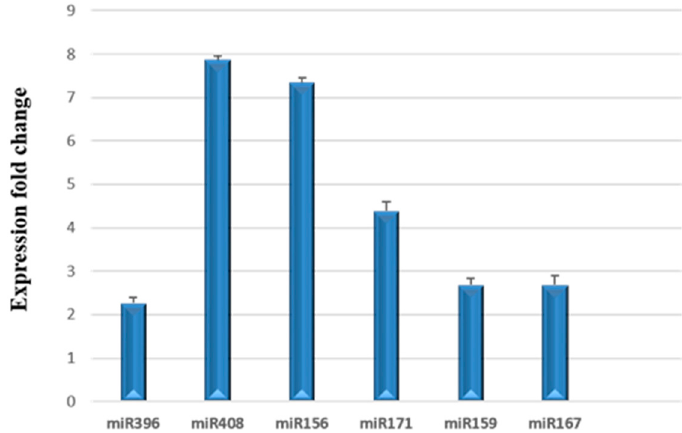
Figure 5. Stem ‐ loop quantitative RT ‐ PCR of miRNA accumulation in TPMVd ‐ infected leaf tissue 4 w. p.i. relative to mock ‐ inoculated controls to which a value of 1 was assigned. U6snRNA was used as an internal reference. Error bars indicate two times the value of SD for the corresponding data set. All fold changes were statistically significant from mock ‐ inoculated controls when analyzed using a paired t ‐ test ( p < 0.05).